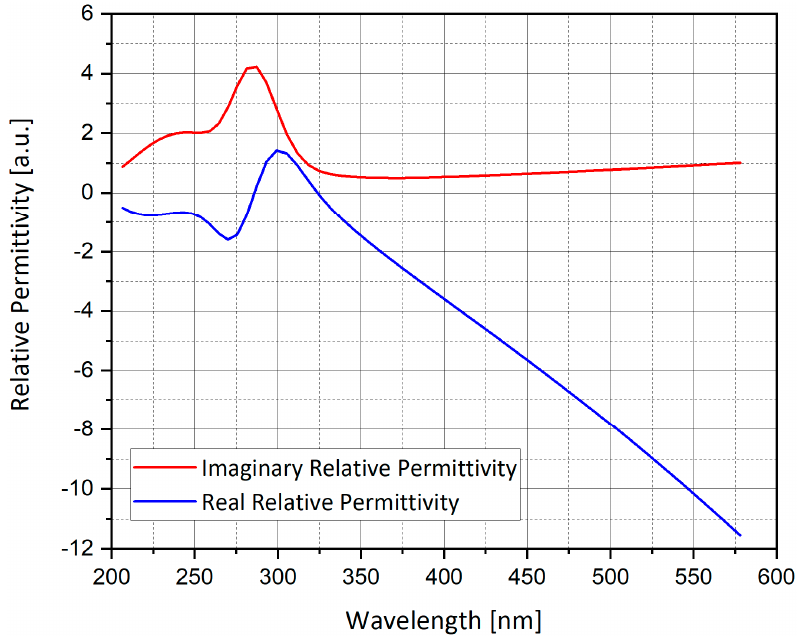
Figure 2. Real and imaginary part of the relative permittivity of silver (Ag).